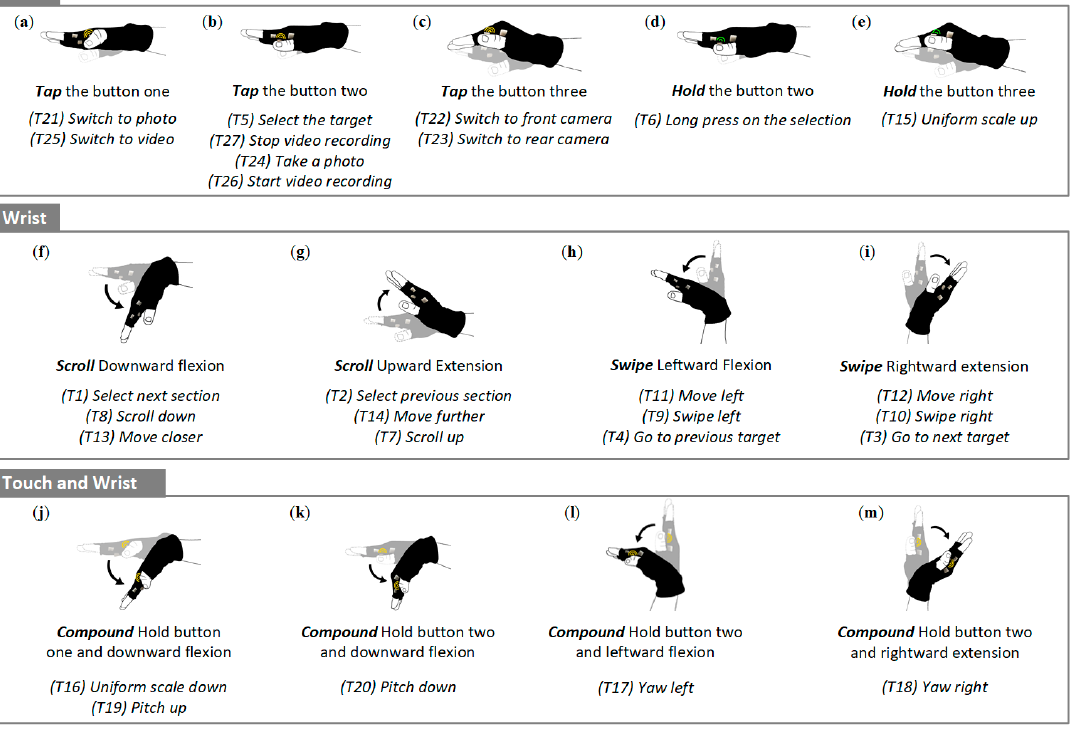
Figure 7. User-preferred gesture set for HAR interactions. Simple touch gestures: ( a ) tap button one, ( b ) tap button two, ( c ) tap button three, ( d ) hold button two, ( e ) hold button three; Simple wrist gestures: ( f ) downward flexion, ( g ) upward extension, ( h ) leftward flexion, ( i ) rightward extension; Complex gestures: ( j ) hold button one and downward flexion, ( k ) hold button two and downward flexion, ( l ) hold button two and leftward flexion, ( m ) hold button two and rightward extension.